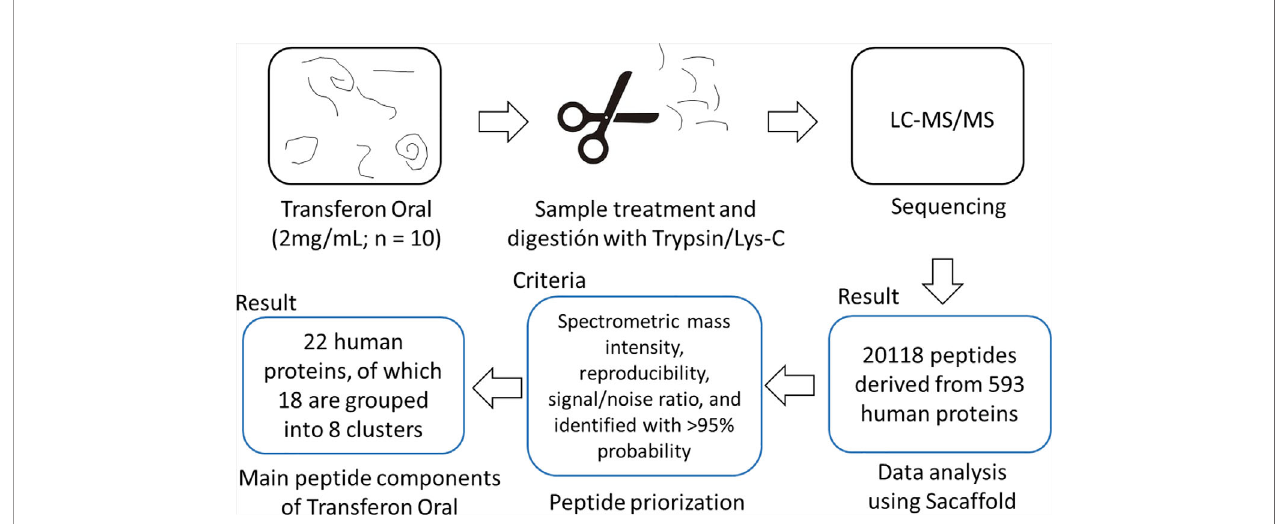
FIGURE 1 | Sequencing analysis of Transferon by MS. Transferon peptides were digested using Trypsin/Lys-C and sequenced by LC-MS/MS. The obtained peptide mass spectrum were prioritized based on its mass intensity, reproducibility among batches, signal and identi fi cation reliability. The batch-to-batch reproducible peptides of Transferon come from 22